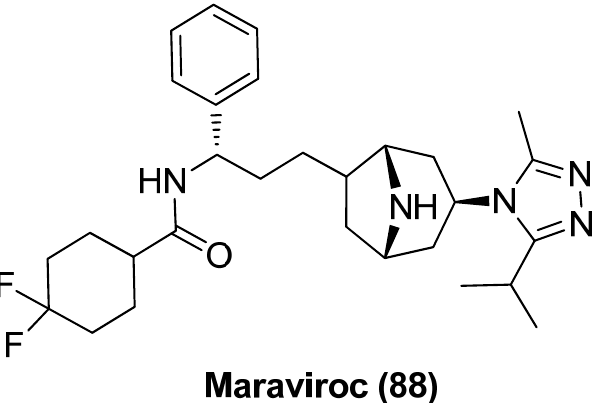
Figure 18. CCR5 antagonist maraviroc (88) as LRA.